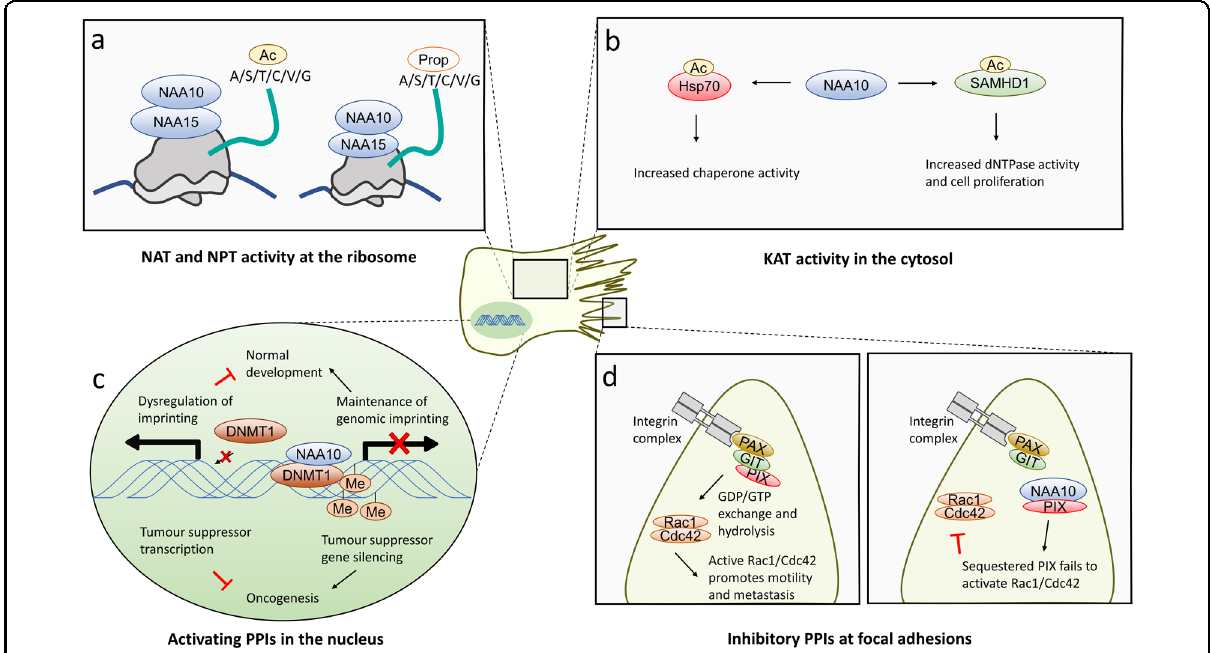
Fig. 5 Functions of NAA10. a NAA10 functions as a cotranslational NAT as part of the NatA complex on the ribosome, acetylating small or polar amino acids (alanine, serine, threonine, cysteine, valine, or glycine). It also has N-terminal propionyltransferase (NPT) activity toward the same substrates as for its NAT activity, transferring a propionyl group (Prop) to the N-terminus, albeit at a signi fi cantly lower frequency than Nt-acetylation. b As a lysine acetyltransferase (KAT), NAA10 acetylates Hsp70, causing it to shift towards chaperone activity. It acetylates SAMHD1, enhancing its dNTPase activity and promoting cancer cell proliferation. c NAA10 binds DNMT1 and mediates its interaction with DNA. DNMT1 then imprints DNA. Loss/depletion of NAA10 leads to dysregulation of this imprinting and inhibits normal development, but it may also suppress oncogenesis. d NAA10 interaction with PIX prevents the formation of the GIT/PIX/paxillin complex at focal adhesions, inhibiting GDP/GTP exchange on Rac1/Cdc42 and subsequent cell motility. NAT N-terminal acetyltransferase, KAT lysine acetyltransferase, NPT N-terminal propionyltransferase, A alanine, S serine, T threonine, C cysteine, V valine, G glycine, Ac acetyl group, Prop propionyl group, NAA N- α -acetyltransferase, SAMHD1 SAM domain and HD